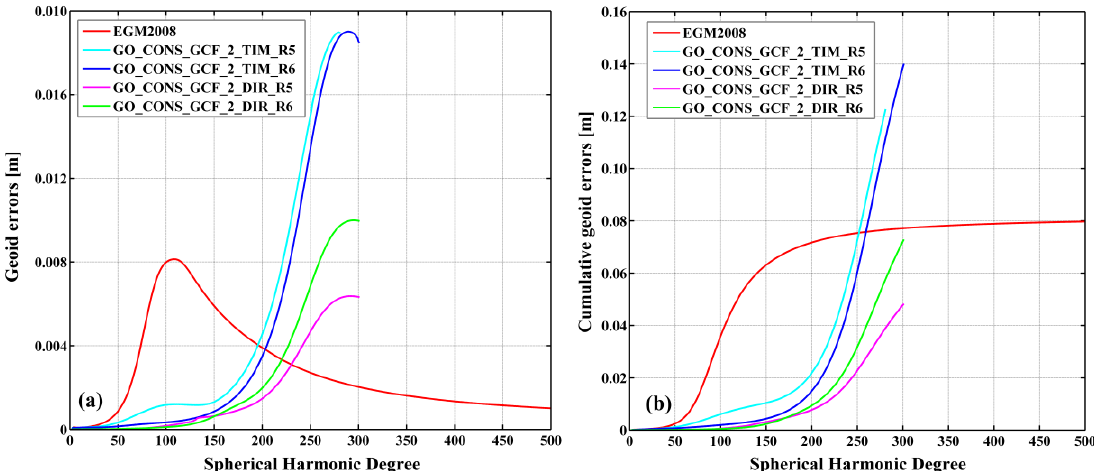
Figure 5. ( a ) Geoid degree error and ( b ) cumulative geoid degree errors for GFMs.